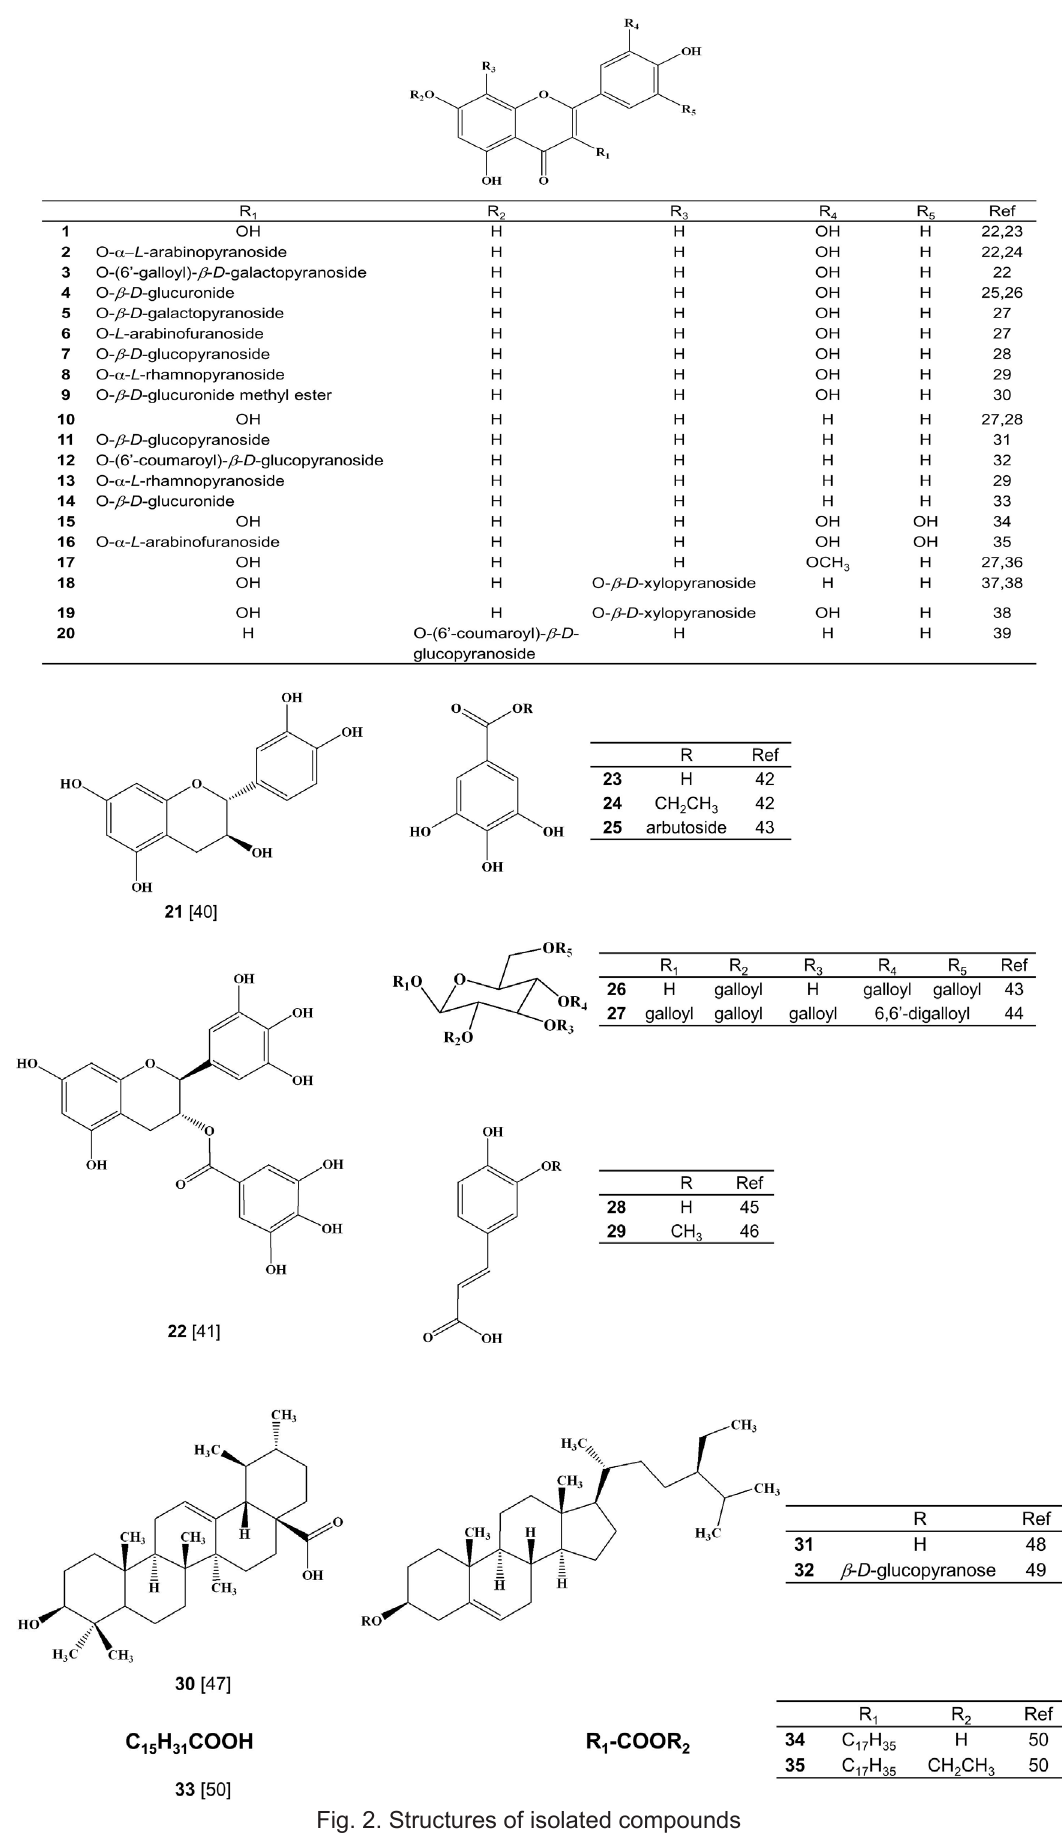
Fig. 2. Structures of isolated